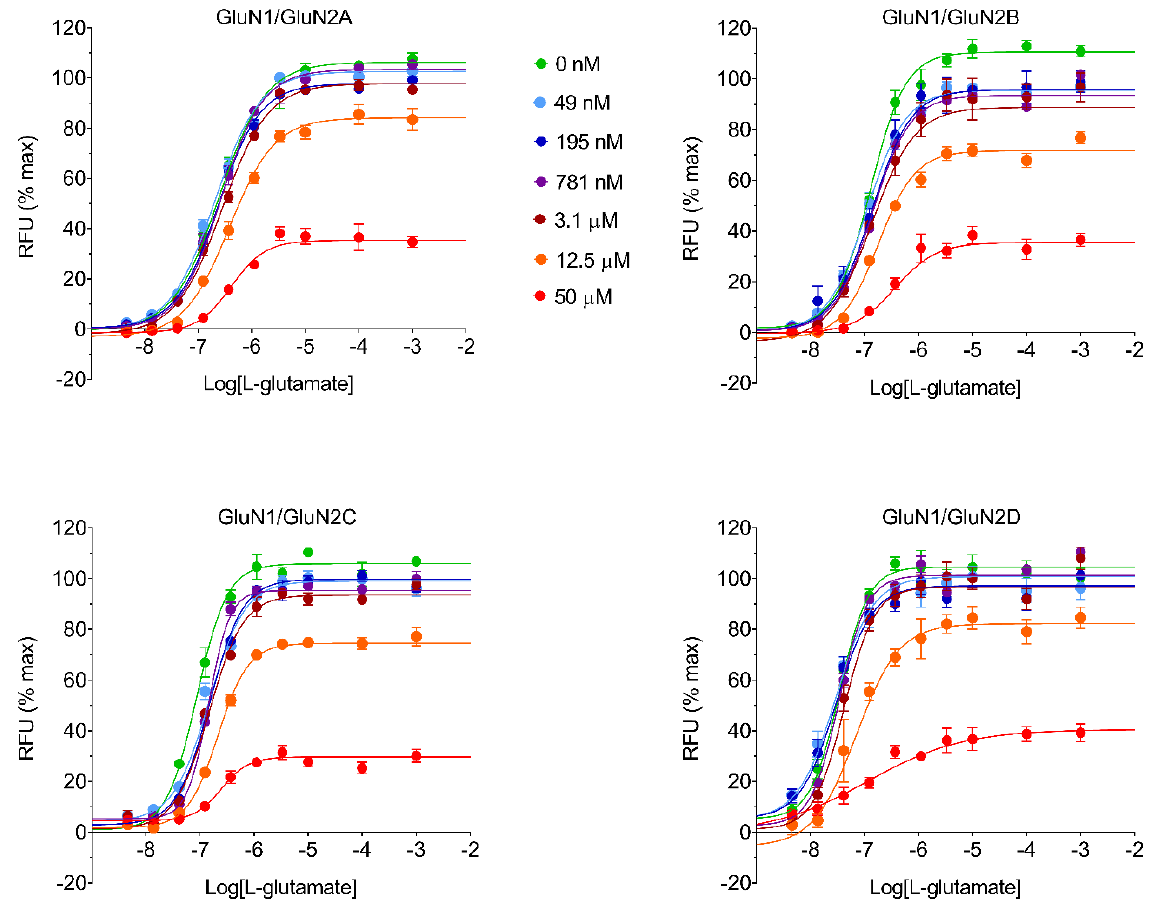
Figure 2. REL-1017 effect on L-glutamate CRC was obtained in a FLIPR Ca 2+ assay to estimate REL-1017 K B . REL-1017 K B is the equilibrium dissociation constant of the REL-1017 receptor complex and the REL-1017 concentration required to occupy 50% of the total NMDAR population. The graphs show L-glutamate CRCs alone ( ● ) or in the presence of six different concentrations of REL-1017 ( ● 50 µM, ● 12.5 µM, ● 3.1 µM, ● 781 nM, ● 195 nM, and ● 49 nM) using four different CHO cell lines expressing heterodimeric human NMDARs: NR1-2A, NR1-2B, NR1-2C, and NR1-2D. An operational equation for allosteric modulators was used to estimate REL-1017 K B and is reported in Table 2. The insur- mountable antagonism demonstrated by REL-1017 is apparent from the graphs, as inhibition induced by high concentra- tions of REL-1017 (e.g., ● 50 µM) cannot be overcome even by agonist concentrations as high as 1 mM L-glutamate. RFU is relative fluorescence